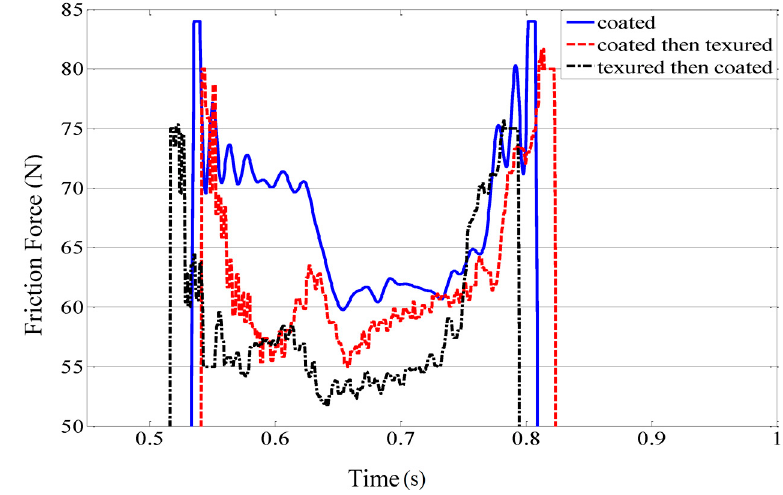
Figure 5. Magnified picture of friction force versus time at 120 rpm for coated, coated and textured, and textured and coated rings.